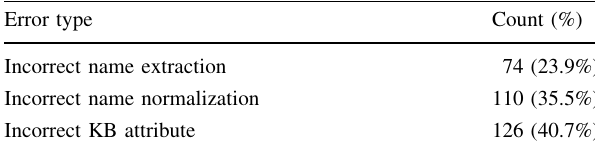
Table 4 Distribution of errors in test